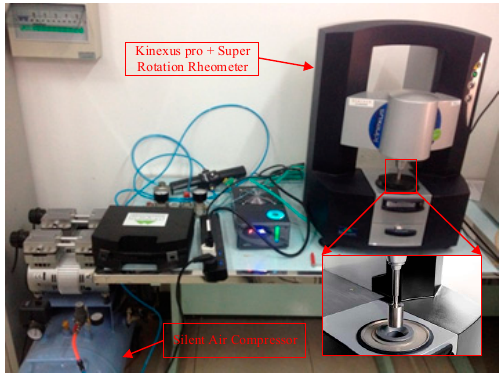
2 O 3 -water nanofluids.